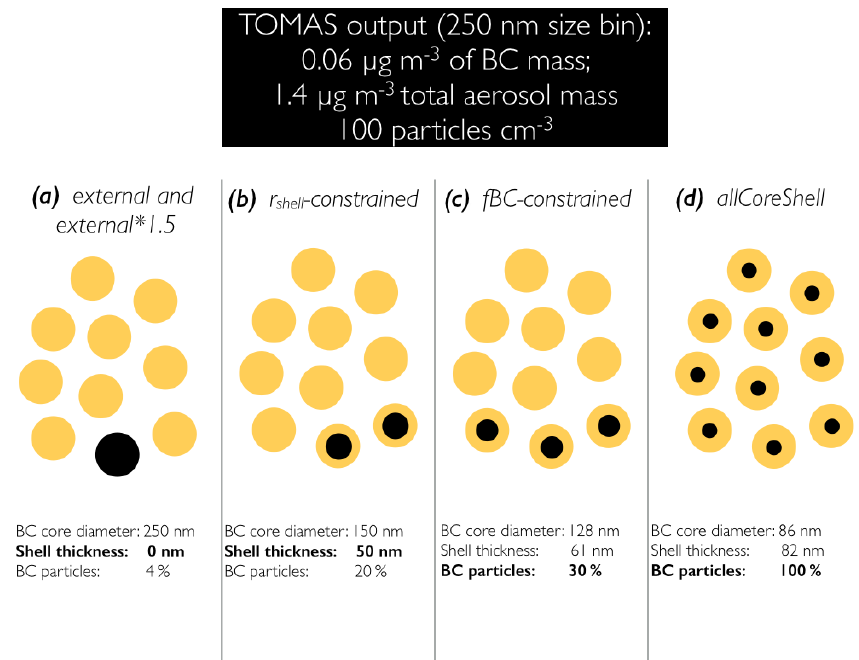
Figure 2. Schematic presenting the different BC mixing states for the TOMAS size bin corresponding to particle diameters of 250nm. The bold text shows the parameter being constrained in each mixing state. In this example, GEOS-Chem–TOMAS simulates 4% BC mass fraction and a particle number concentration of 100cm − 3 . In the external mixing-state assumption, all BC mass forms separate particles (rounded to 1 particle out of 10 for convenience), while in the allCoreShell mixing-state assumption, all BC mass is spread among all particles. The r shell -constrained mixing state uses SP2 measurements to constrain BC core diameter and shell thickness. The fBC-constrained mixing state uses BC-containing particle fractions from the SP2 and UHAS as the constraint on mixing